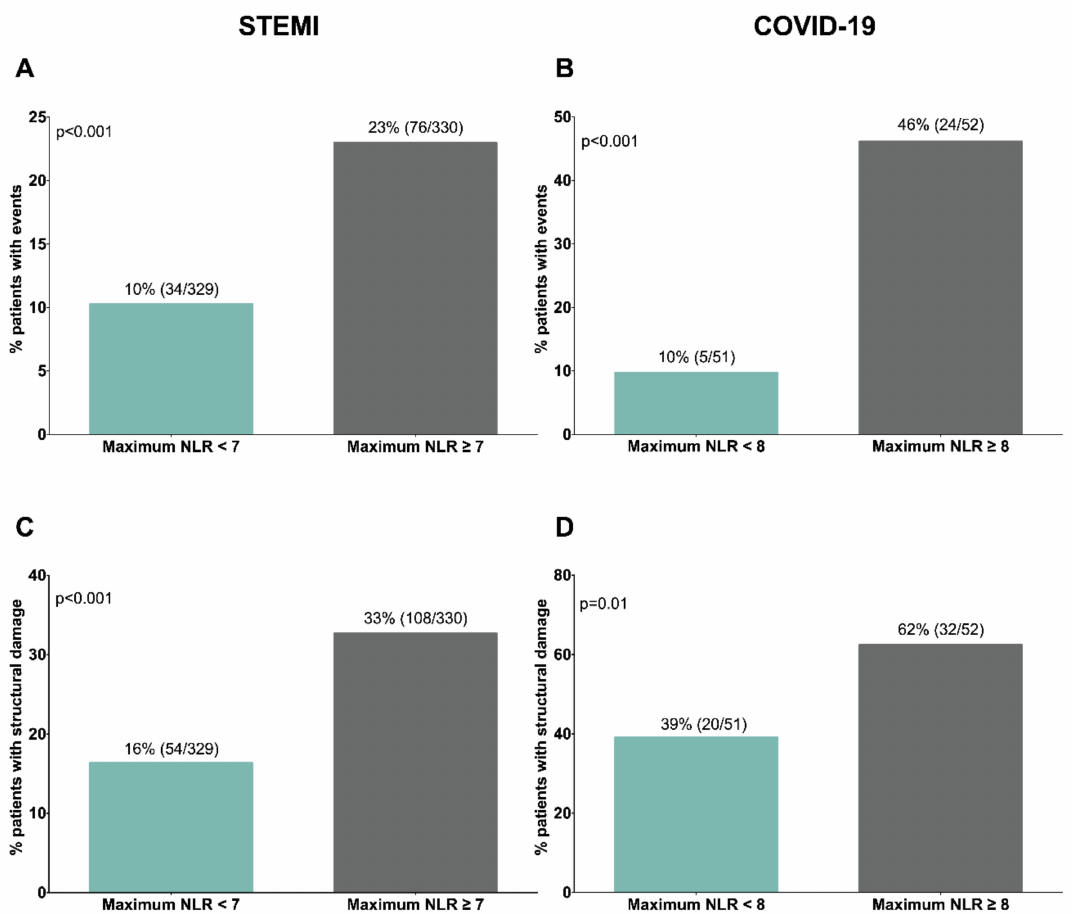
Figure 8. Percentage of patients experiencing adverse events or severe structural damage according to maximum NLR in STEMI and COVID-19 cohorts. Both populations were dichotomized according to the median value of maximum NLR (STEMI: 7 and COVID-19: 8). Percentage of patients showing adverse events: ( A ) STEMI: death and / or heart failure; ( B ) COVID-19: death and / or admission into ICU) or severe structural damage; ( C ) STEMI: CMR-derived infarct size > 30% of left ventricular mass; ( D ) COVID-19: CT-derived bilateral pneumonia) according to maximum NLR. CMR: cardiac magnetic resonance; COVID-19: coronavirus disease 2019; CT: computed tomography; ICU: intensive care unit; NLR: neutrophil-to-lymphocyte ratio; STEMI: ST-segment elevation myocardial